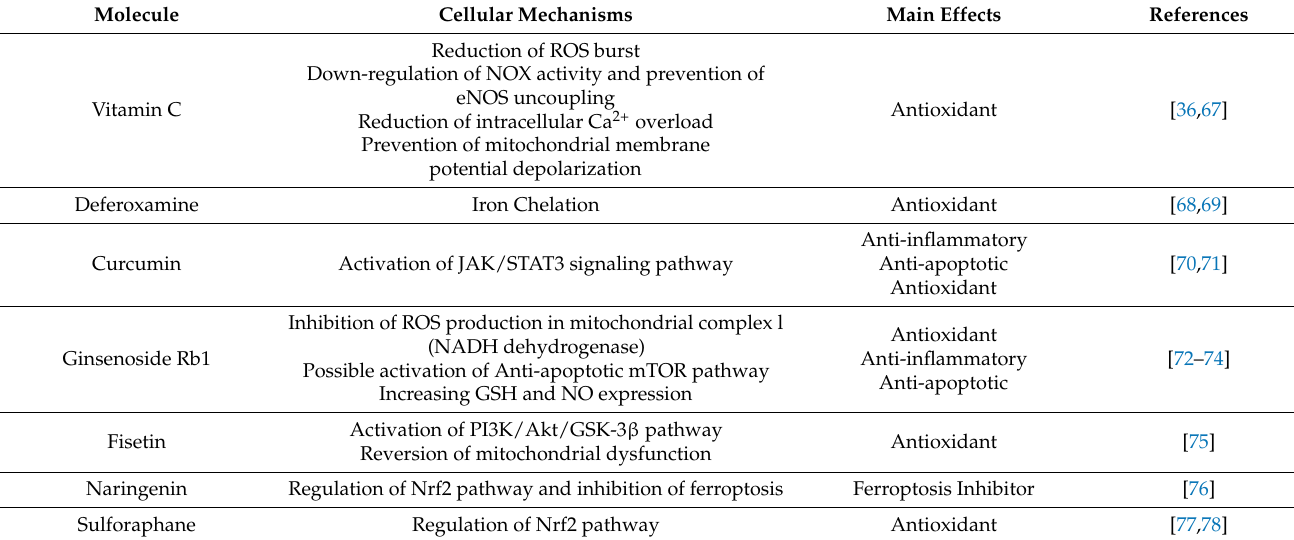
Table 1. Natural Antioxidants.